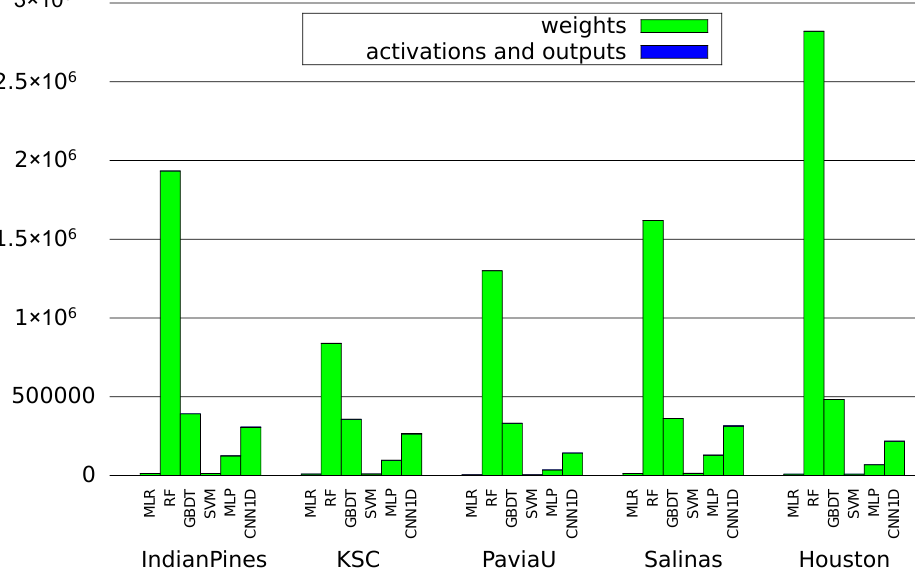
Figure 5. Size of the trained models in bytes.